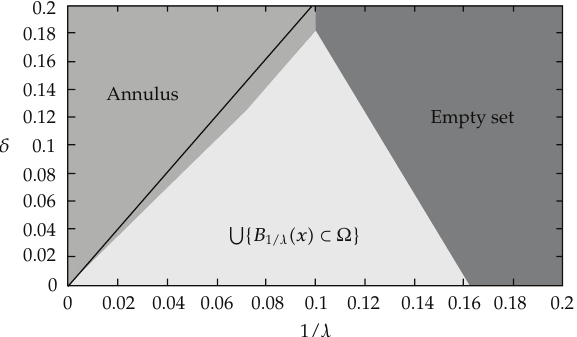
Figure 3: This diagram shows the Σ i with minimum value in (cid:4) 1.2 (cid:5) for the nonconcentric